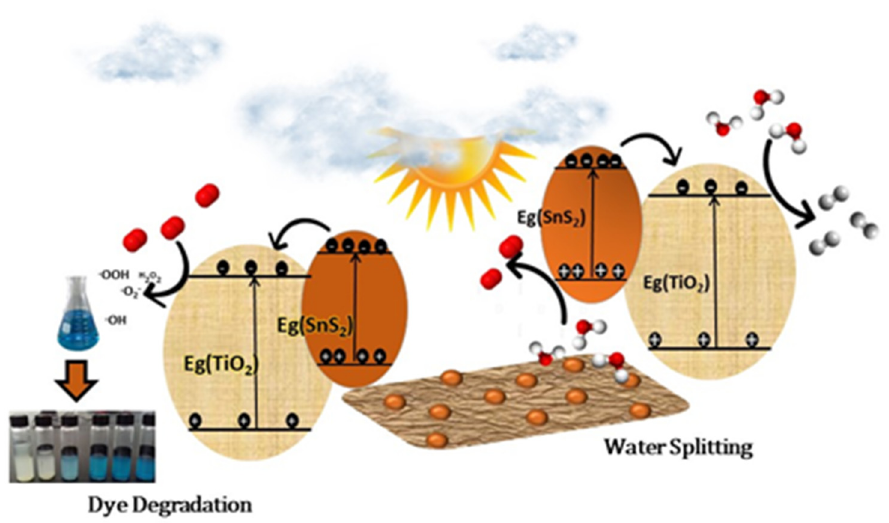
Figure 7. Photocatalytic mechanism.